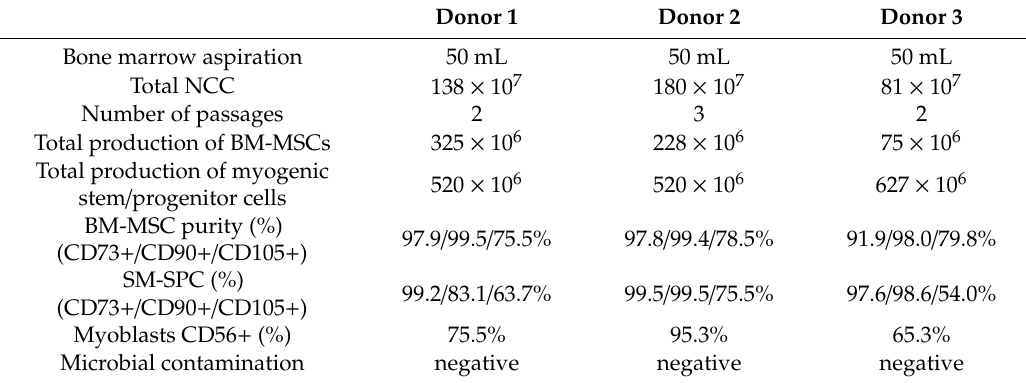
Table 2. Characteristics of BM-MSCs and myogenic stem / progenitor